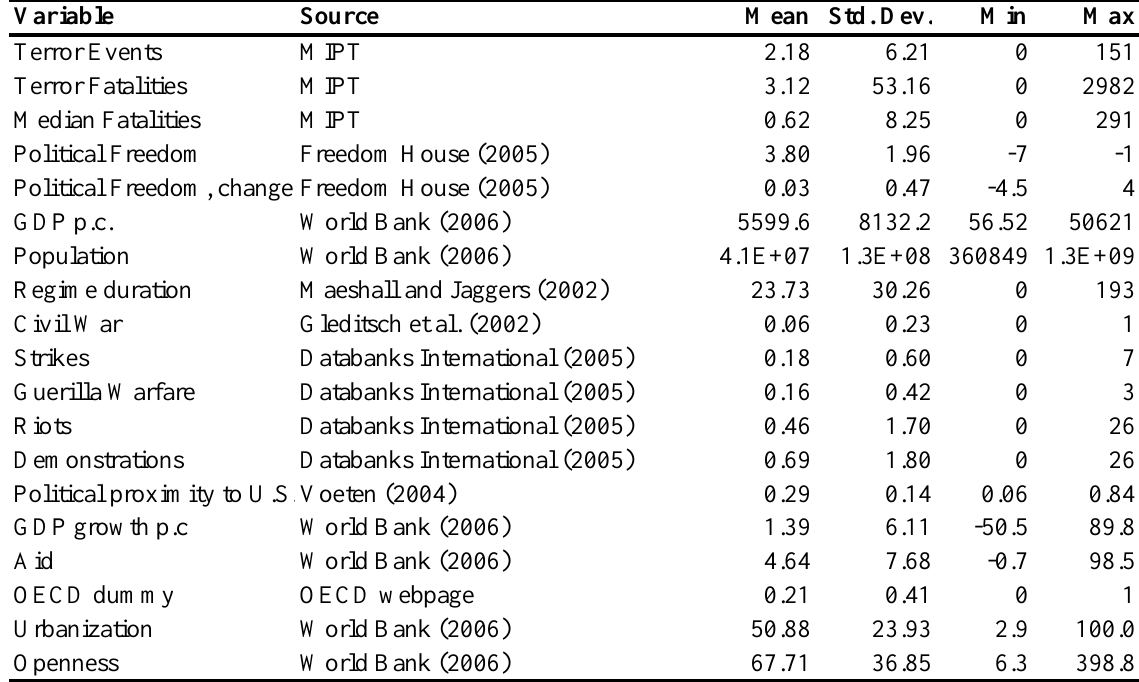
Table 2: Summary Statistics and